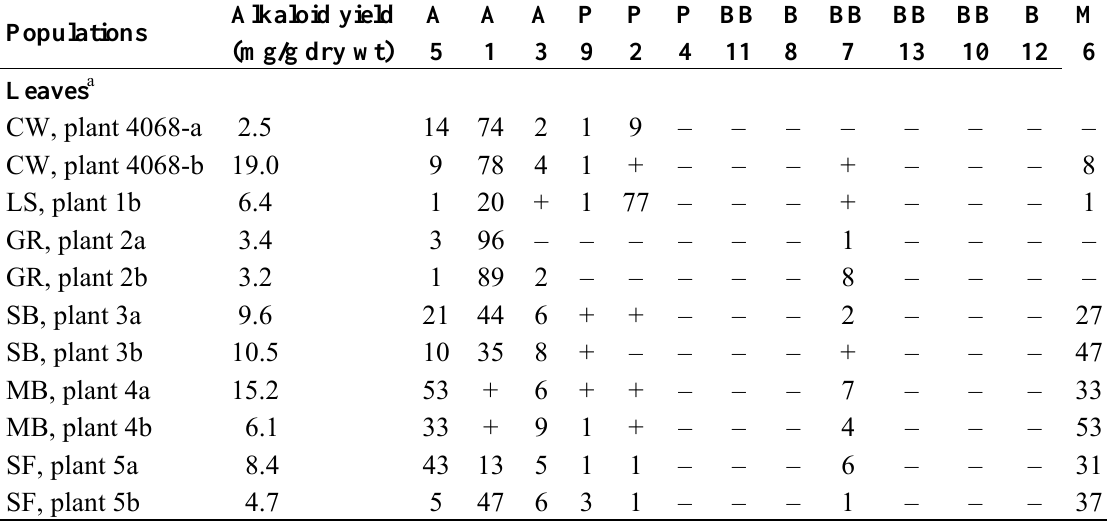
structural types ( A aporphine, P proaporphine, BB bisbenzyltetrahydroisoquinoline, B benzyltetrahydro-isoquinoline, M morphinane) and numbered as in Figure 1. In column